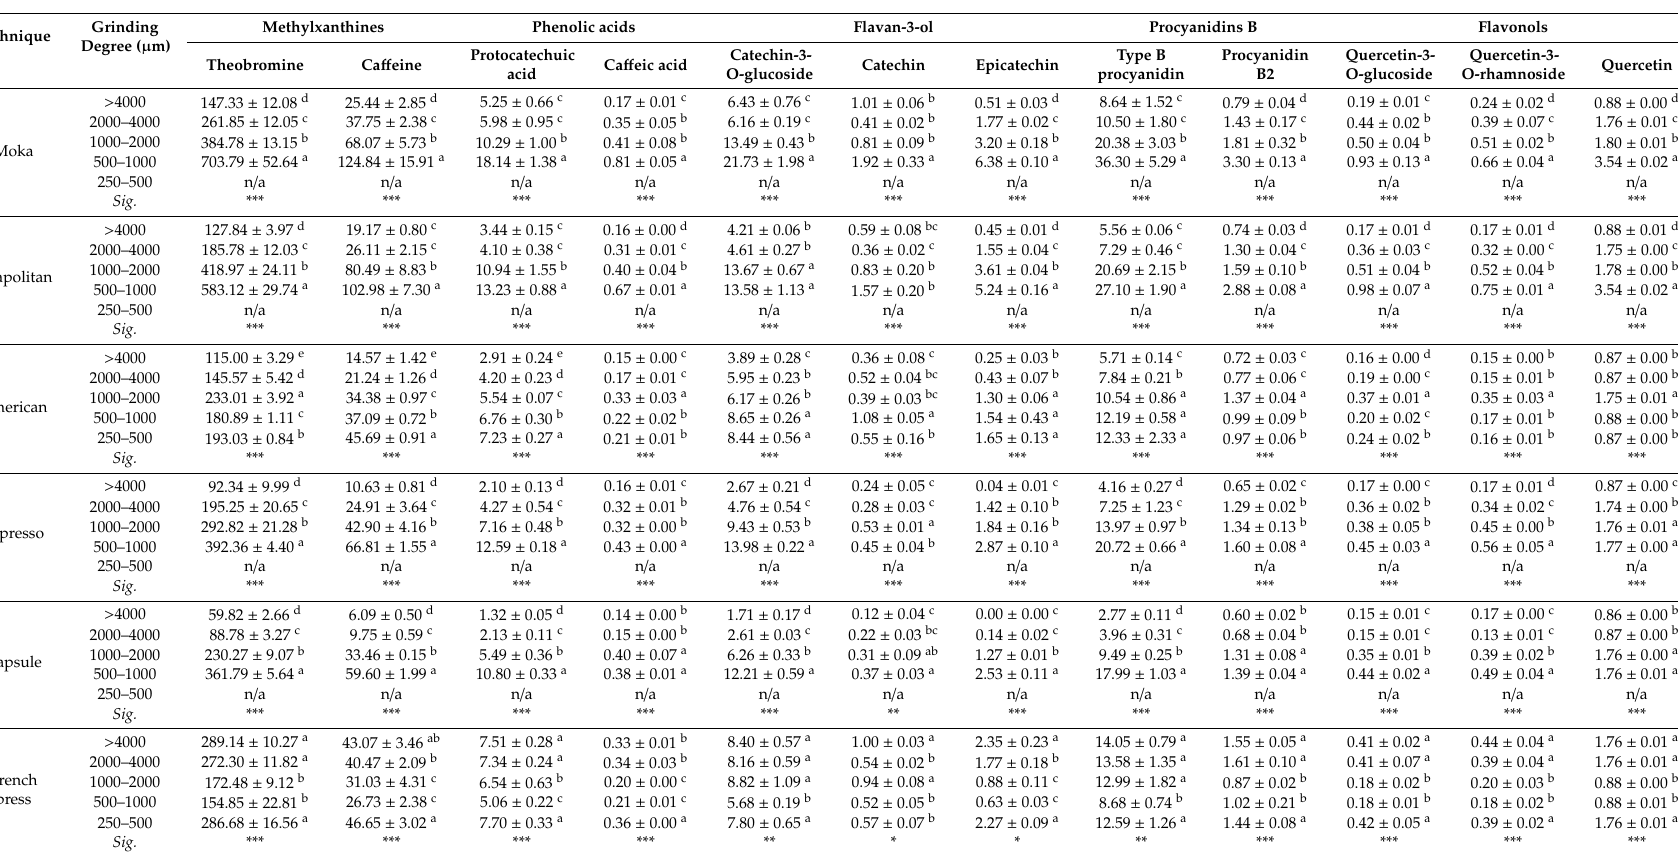
Table 3. Content (mg / L) of methylxanthines (theobromine and ca ff eine) and polyphenols (phenolic acids, flavan-3-ols, procyanidins B, and flavonols) evaluated by HPLC for the beverages obtained via the di ff erent techniques and GDs of the CBS and ANOVA among GDs for each technique.